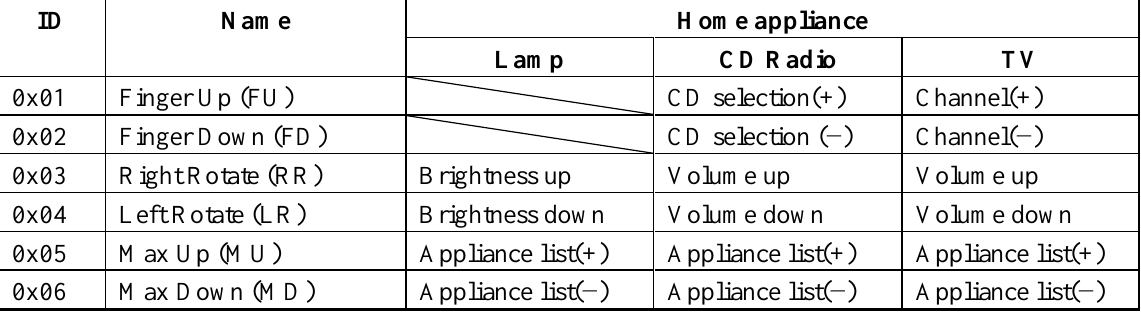
Table 1. Semantic matching between gestures and control